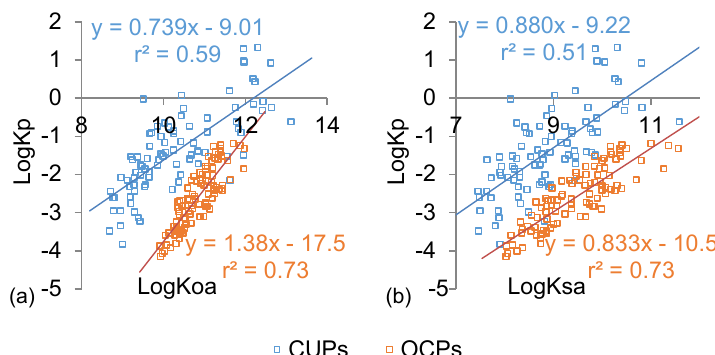
Figure 2. Comparison of log K p with log K oa (a) and with log K sa (b) for OCPs and CUPs.